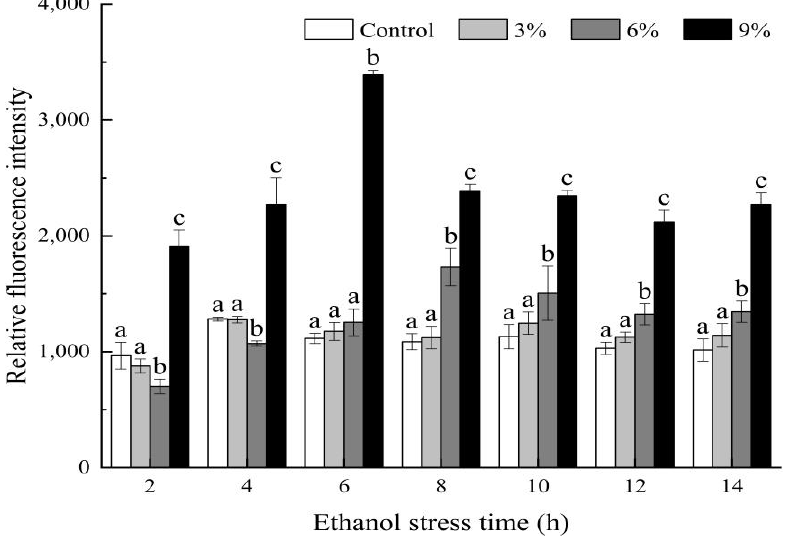
Figure 5. Effects of ethanol stress on ROS content of P. anomala NCU003 (different alphabet represents a significant difference ( p < 0.05) at the same time).